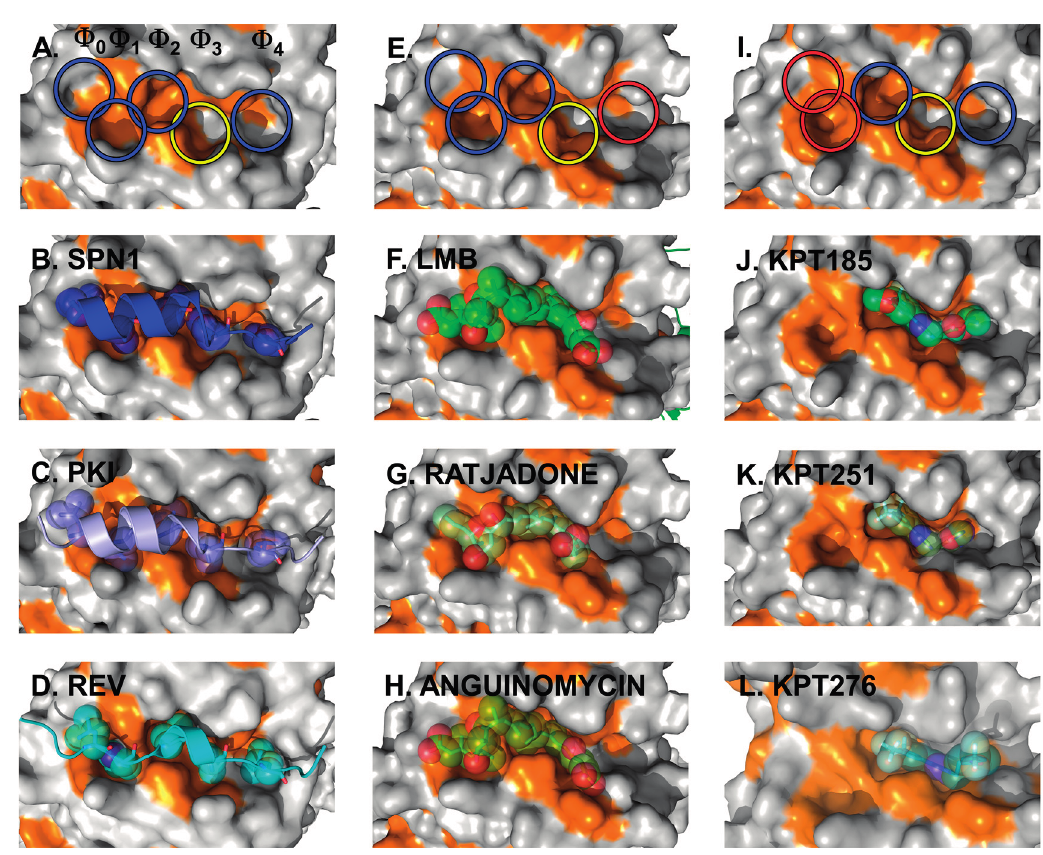
Figure 4. Cargo and inhibitor binding via the NES-binding cleft. Structural features of the NES-binding cleft of CRM1 is shown at the top. The five hydrophobic binding pockets for the interacting residues of the NESes are indicated by circles, with blue and yellow indicating the occupied sites and red circles highlighting the sites unused by the inhibitors depicted in the panels below. Additionally, the yellow circle indicates the position of Cys528 in human CRM1 and the S539C mutation in yeast CRM1 used for covalent binding of the inhibitors. Left panels: three NESes differing with respect to the spacing in between the residues determining binding within a rigid NES-binding pocket are shown. Detailed view of the NES-binding clefts of CRM1 bound to the SPN1-NES ( A , B ) (PDBid: 3GJX), PKI-NES; ( C ) (PDBid: 3NBY); and Rev-NES ( D ) (PDBid: 3NBZ). The SPN1-NES has been removed in ( A ) for clarity reasons to show the dimensions of the cleft and the respective Φ -pockets. Note that the key residues of all three NESes occupy identical Φ -pockets and differences in the Φ -spacing are compensated by a different arrangement of the NES-peptide main chain. Natural inhibitors of cargo binding bound to yeast CRM1 are shown in the middle panels. Blocking of the NES-binding cleft by CRM1-specific natural inhibitors: LMB ( E , F ) (PDBid: 4HAT); as well as Ratjadone ( G ) (PDBid: 4HAU); and Anguinomycin ( H ) (PDBid: 4HAV). LMB has been removed in ( E ) to show the dimensions of the occupied NES-binding cleft. Small synthetic inhibitors and their orientation in the NES-binding cleft are depicted on the right. KPT185 ( I , J ) (PDBid: 4GMX), KPT251; ( K ) (PDBid: 4GPT) and KPT276 (PDBid: 4WVF). KPT185 has been removed in ( I ) to show the dimensions and highlight the individual pockets of the occupied NES-binding